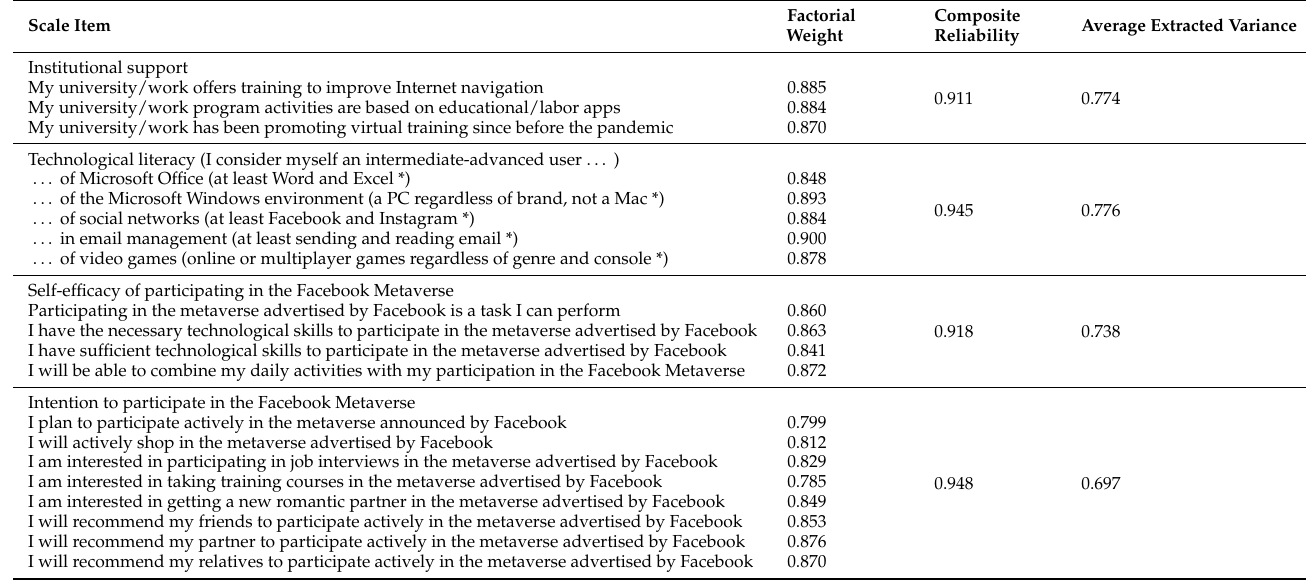
Table 1. Construct validity using